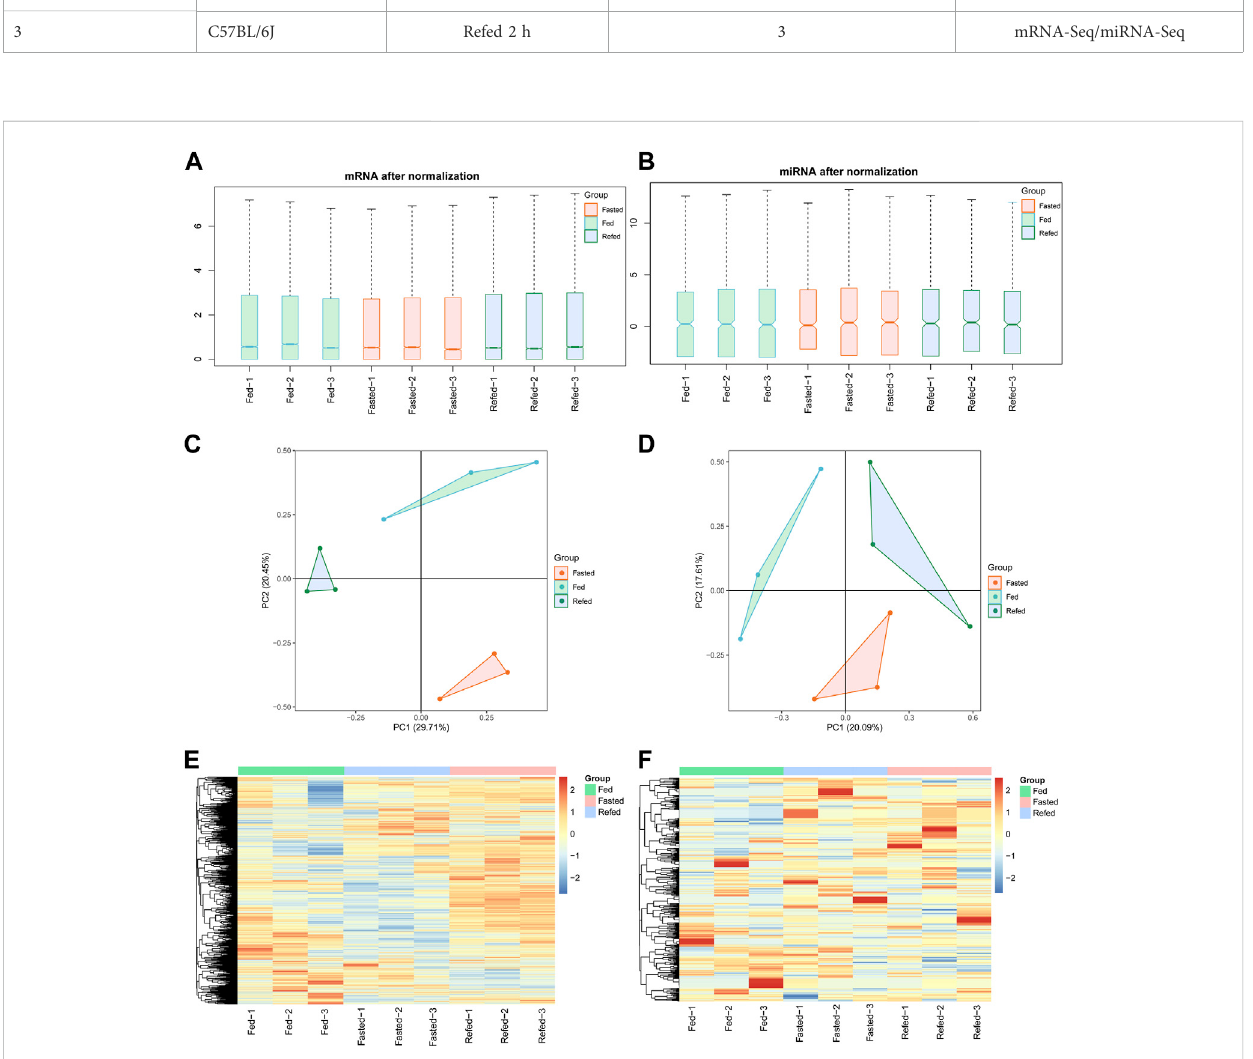
FIGURE 1 Thereproductivityandreliability ofmRNA-Seq andmiRNA-Seqdatasets. (A,B) BoxplotofmRNA (A) andmiRNA (B) expressionafter normalizationin fed, fasted and refed groups. (C,D) PCA analysis showing normalized expression of mRNA (C) and miRNA (D) in fed, fasted and refed groups after batch- effectcorrection. (E,F) HeatmapshowingmRNA € andmiRNA (F)